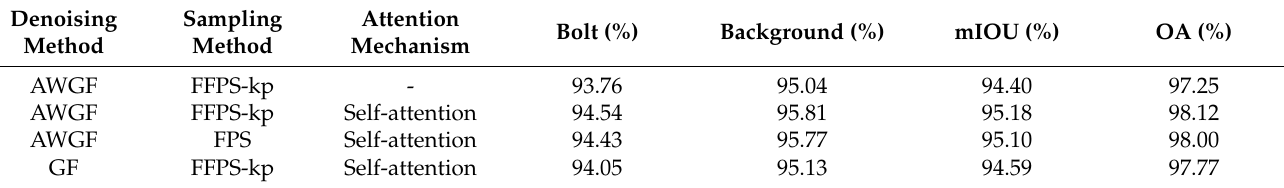
Table 7. Ablation